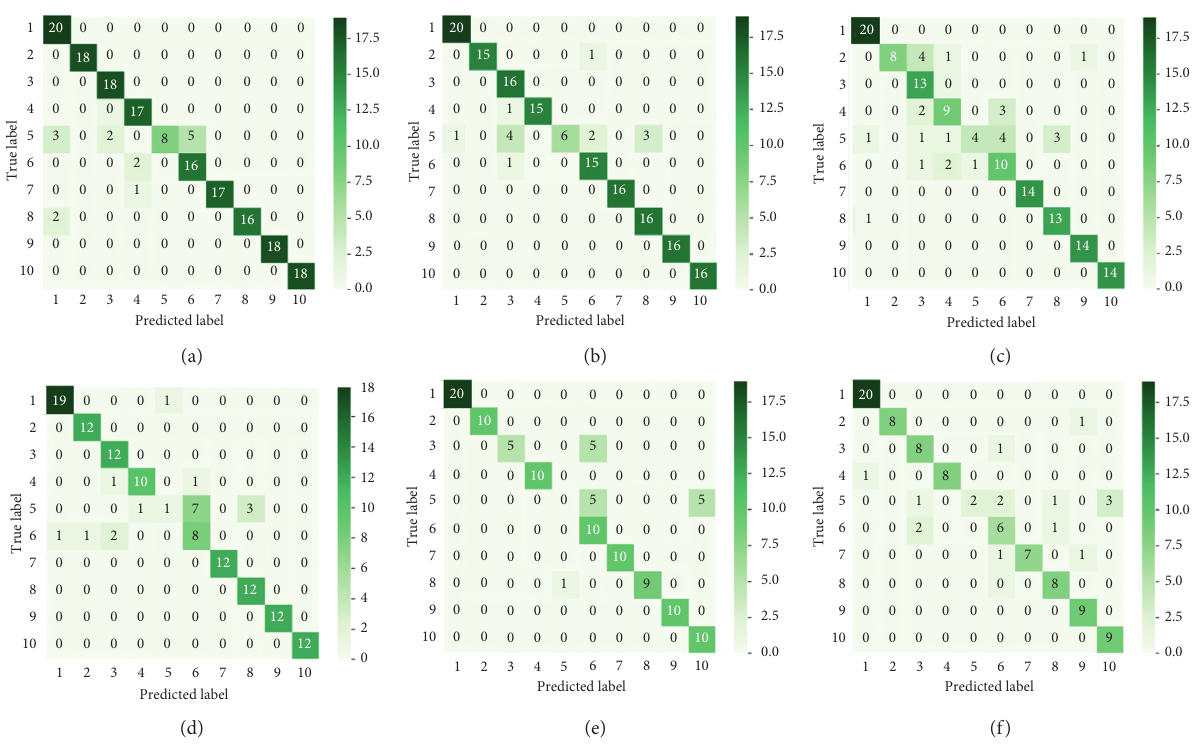
Figure 12: Confusion matrices of WCNN for the ten-classes scenario in different cases. (a) Case 2. (b) Case 3. (c) Case 4. (d) Case 5. (e) Case 6. (f) Case 7.